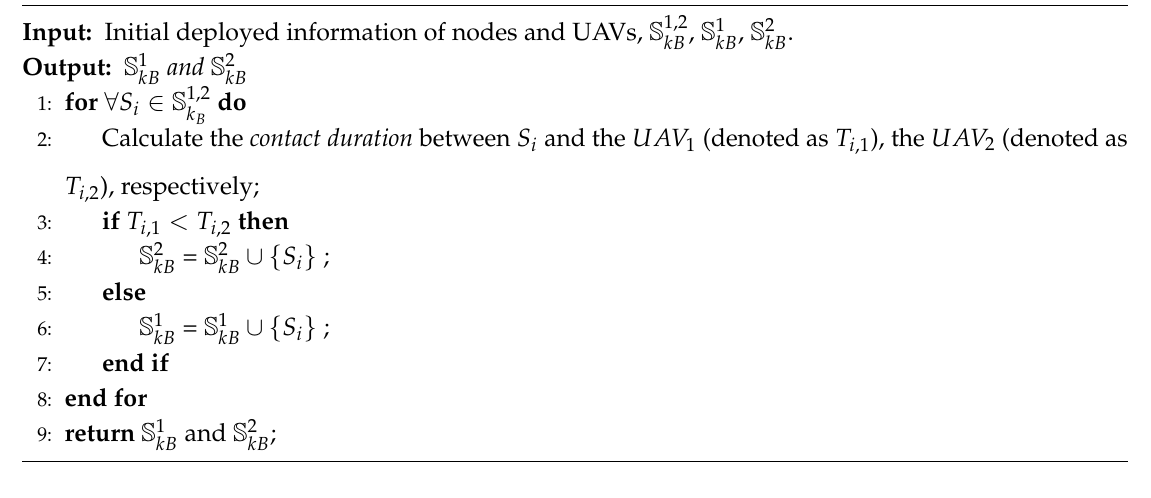
Algorithm 3 Prioritized-based multiple contact-duration frame selection mechanisms (PMCdFS) algorithm.